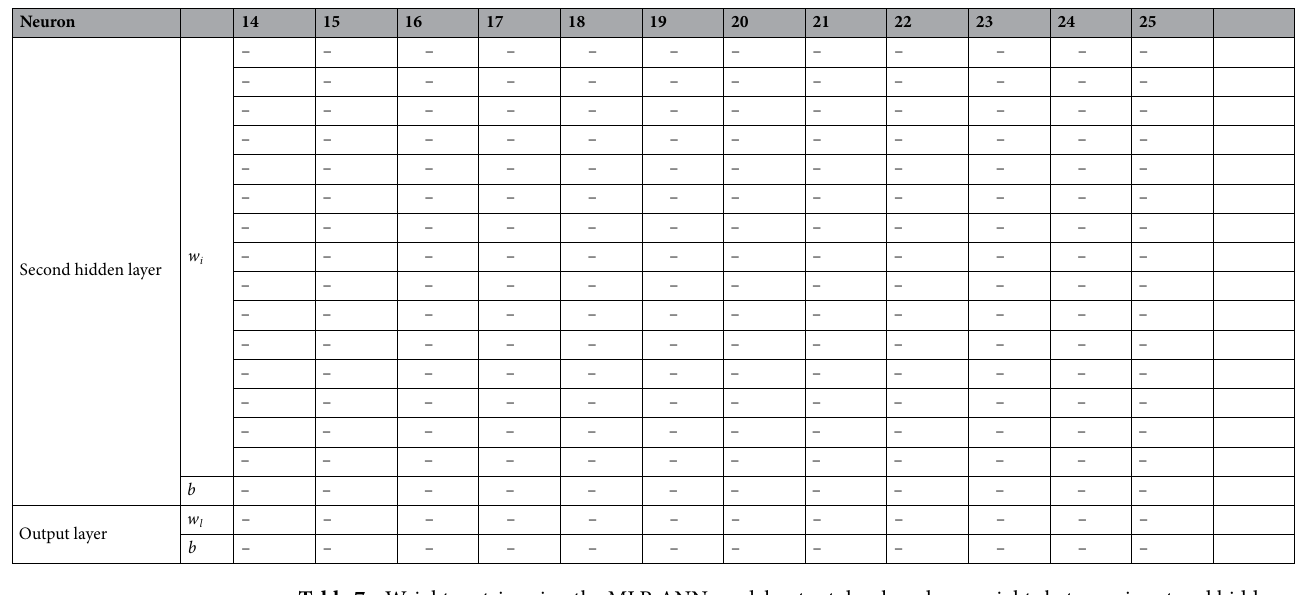
Table 7. Weight matrix using the MLP-ANN model output developed. w i : weights between input and hidden layers. w l : weights between hidden and output